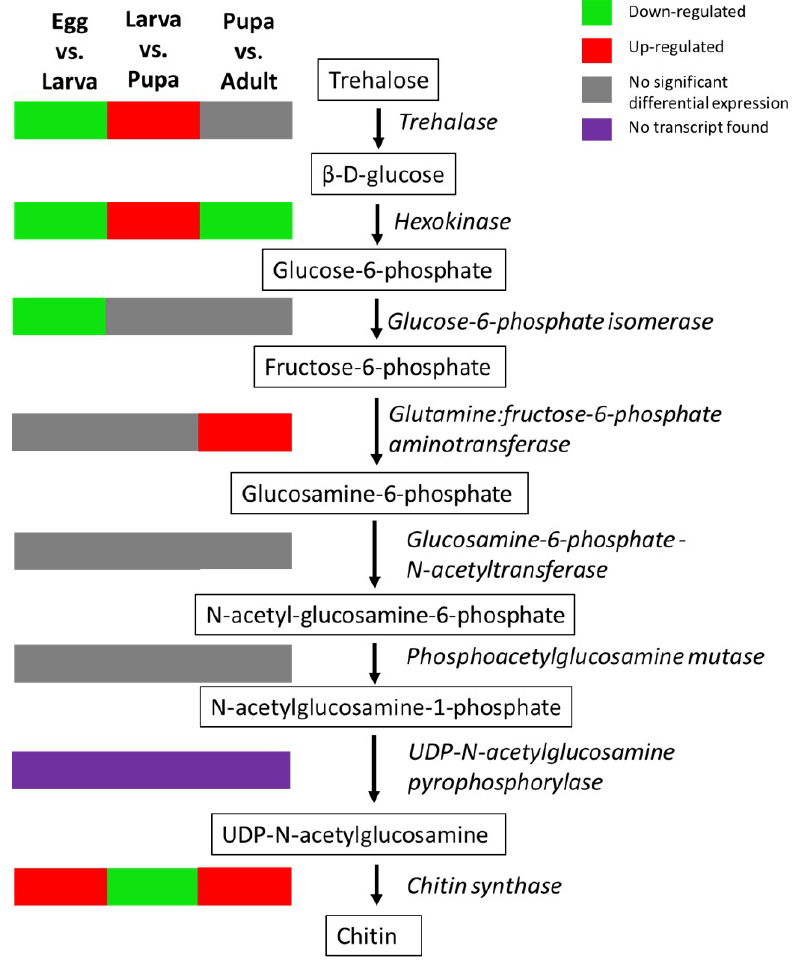
Figure 9. Chitin biosynthesis pathways and expression analysis. The figure shows differentially expressed transcripts (FDR <0.001, |Log2FC| ≥ 2) of M. plana’s chitin biosynthesis pathway in three pairwise comparisons; egg-larva, larva-pupa and pupa-adult. The pathway starts with trehalose, a sugar compound and ends with chitin polymers. The molecular structure of each substrate was adopted from the previous review on the chitin biosynthesis pathway [46]. The enzymes are in italic. The schematic representation is based on previously established pathways [45–47].